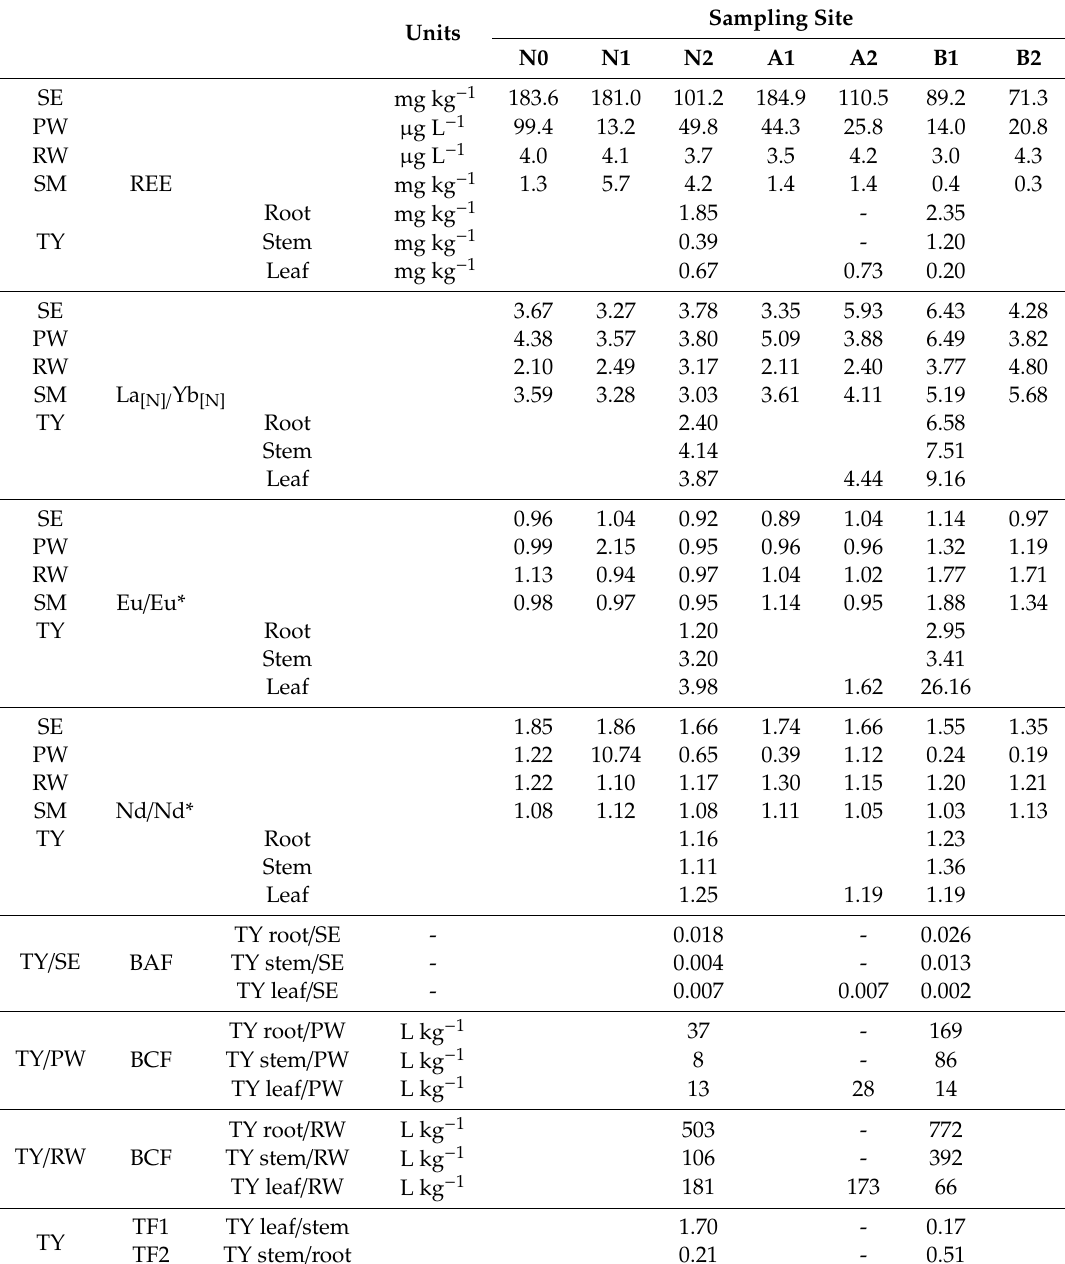
Table 2. REE contents, La [N] / Yb [N] fractionation factors, and Eu / Eu* and Nd / Nd* ratios of sediments (SEs), sediment pore water (PW), river water (RW), suspended material in rivers (SM), and the roots, stems, and leaves of the aquatic plant Typha latifolia L. (TY). The bioaccumulation factors (BAFs), bioconcentration factors (BCFs), and translocation factors in the plant were calculated by dividing the leaf content by the stem content (TF1) and the stem by the root